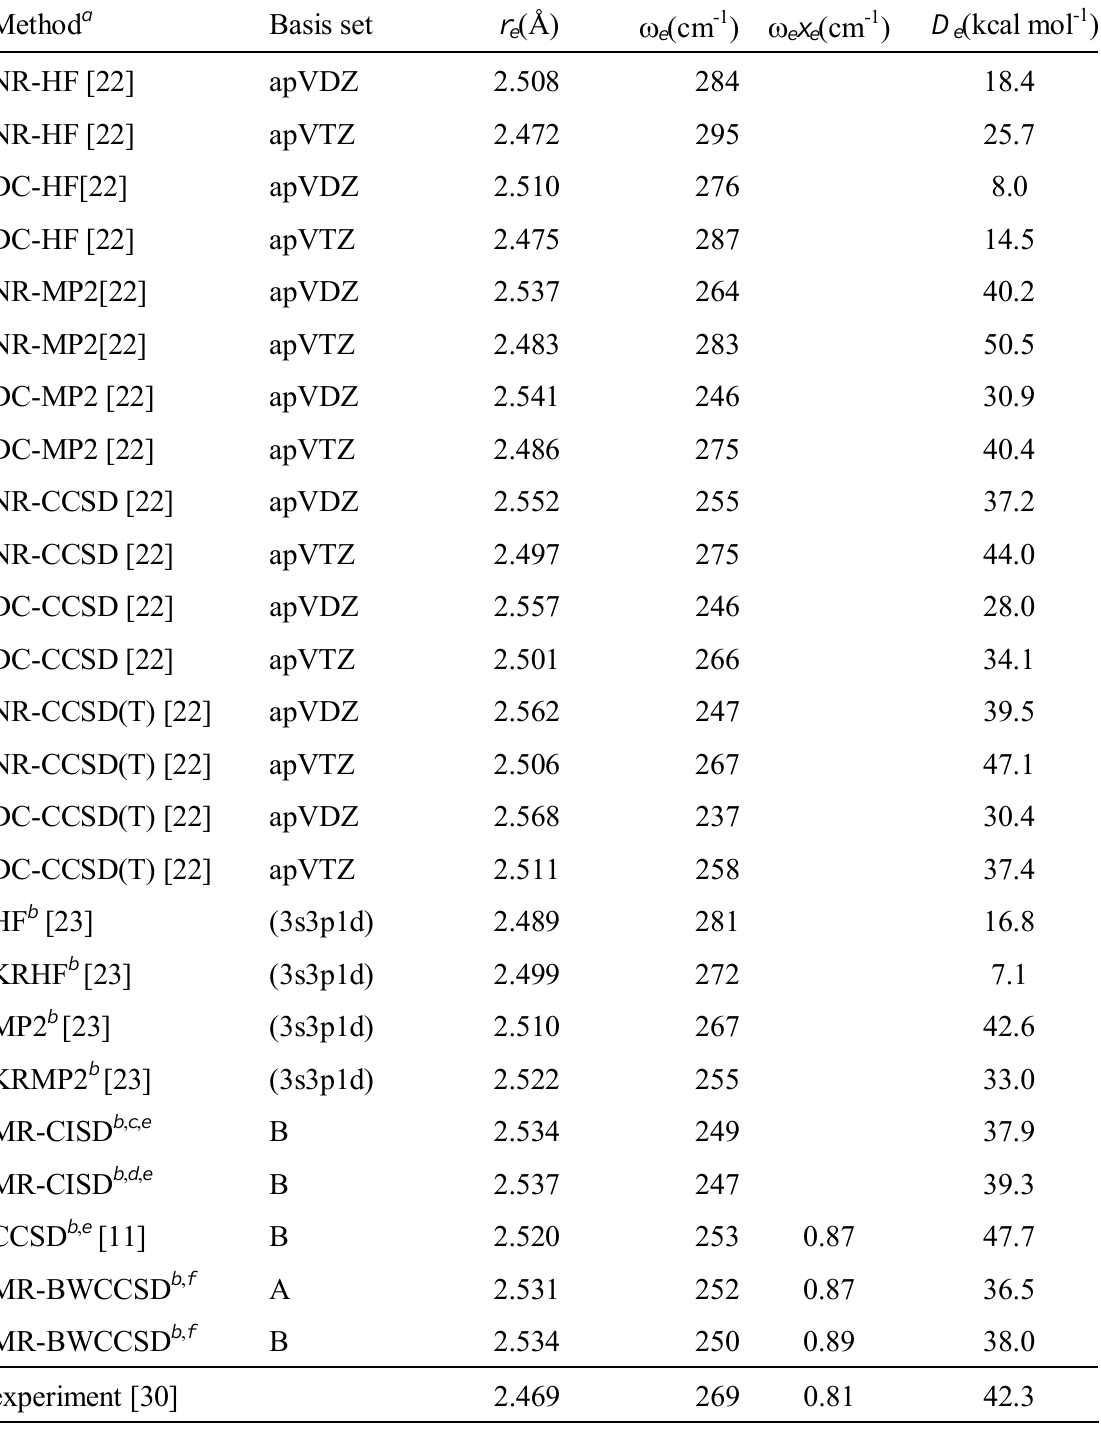
Table 1. Spectroscopic constants of